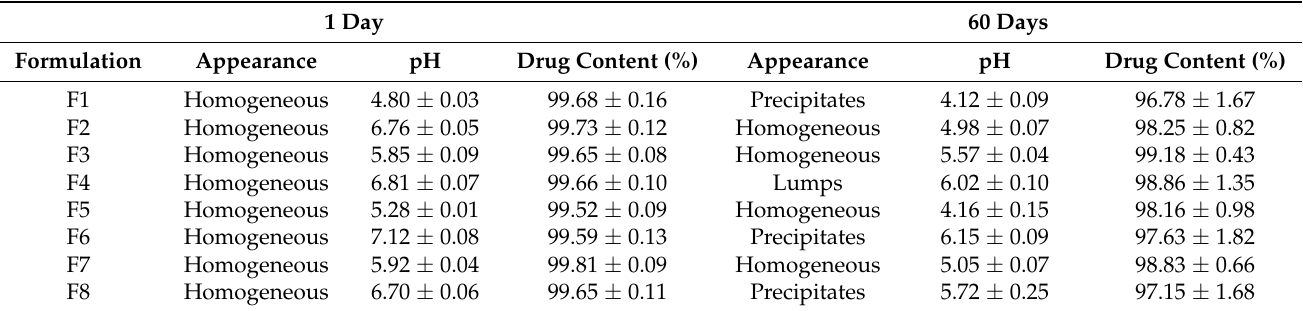
Table 1. Physical and chemical characterization of the 8 formulations obtained by 2 3 factorial experiment after one and 60 days of preparation and storage at 30 °C.